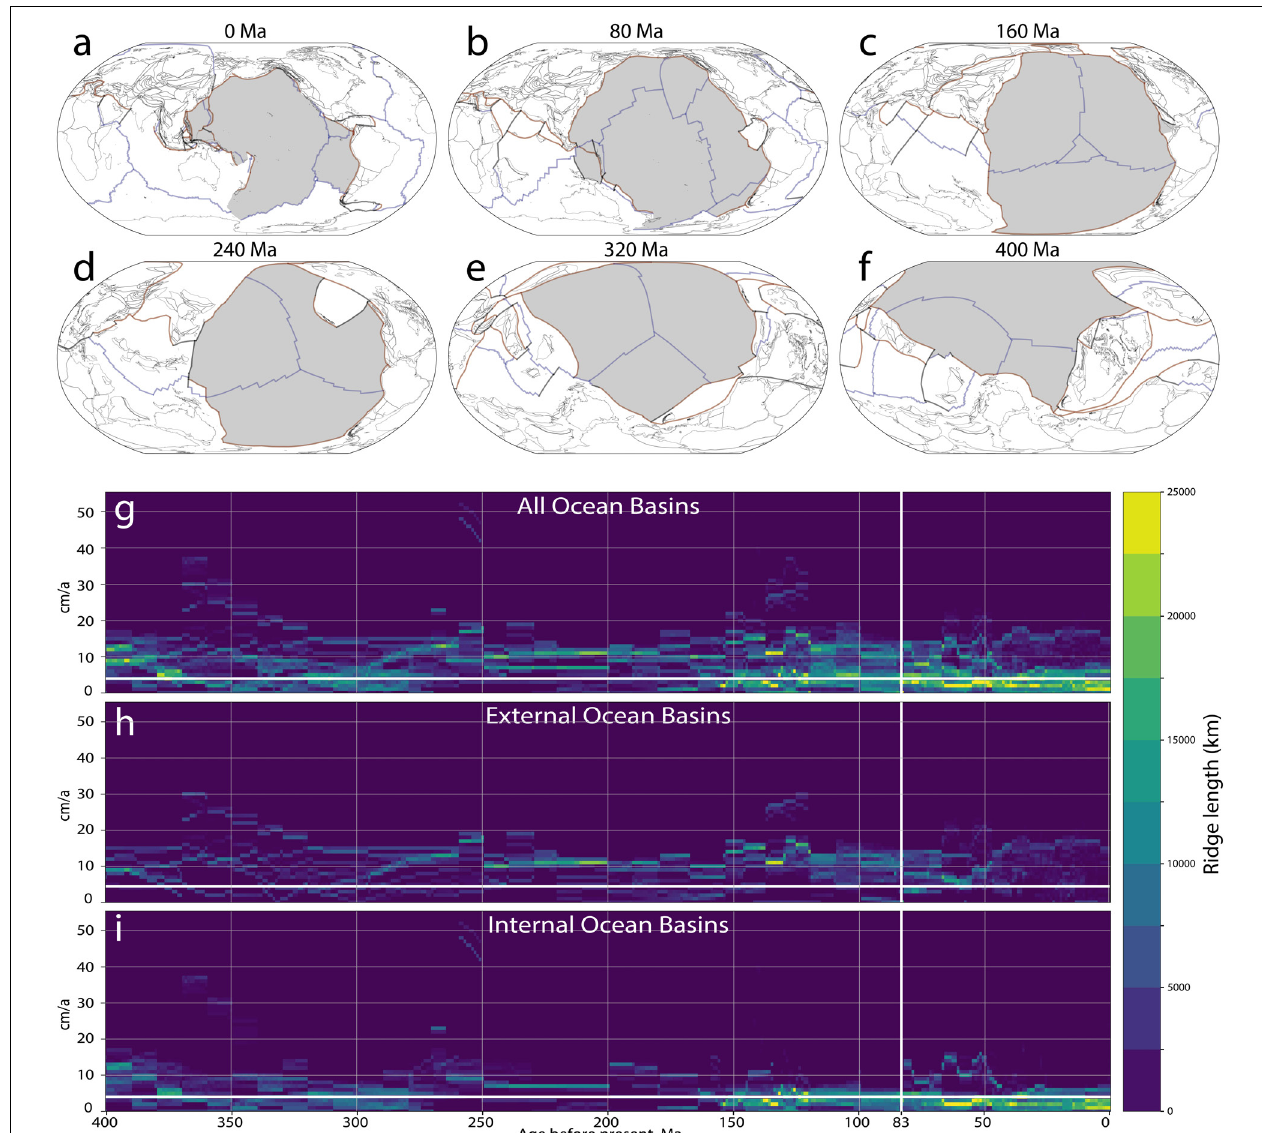
FIGURE 1 | Evolution of the Pacific Ocean used in our analysis. (A–F) Snapshots of the Pacific and Panthalassa Oceans and associated basins used to extract spreading rate distributions (dark gray). All plates constituting the Pacific basin during the last 83 Ma were identified using the model of Matthews et al. (2016). Mid-ocean ridges in blue, subduction zones in brown, and connecting plate boundaries in gray. Tectonic plates highlighted in dark gray are what we considered “external” ocean basins, while internal ocean basins are the remainder. (G–I) show the distribution of full ridge spreading rates sampled at spreading segments in cm/a with (G) all ocean basins, (H) external ocean basins, and (I ) internal ocean basins. The bold vertical white line shows the 83 Ma cut off, where we use the external ocean distribution as an archetype for pre-160 Ma external ocean basins. The horizontal white lines are at 4 cm/a, where in our model we separate amagmatic and magmatic crustal forming processes at